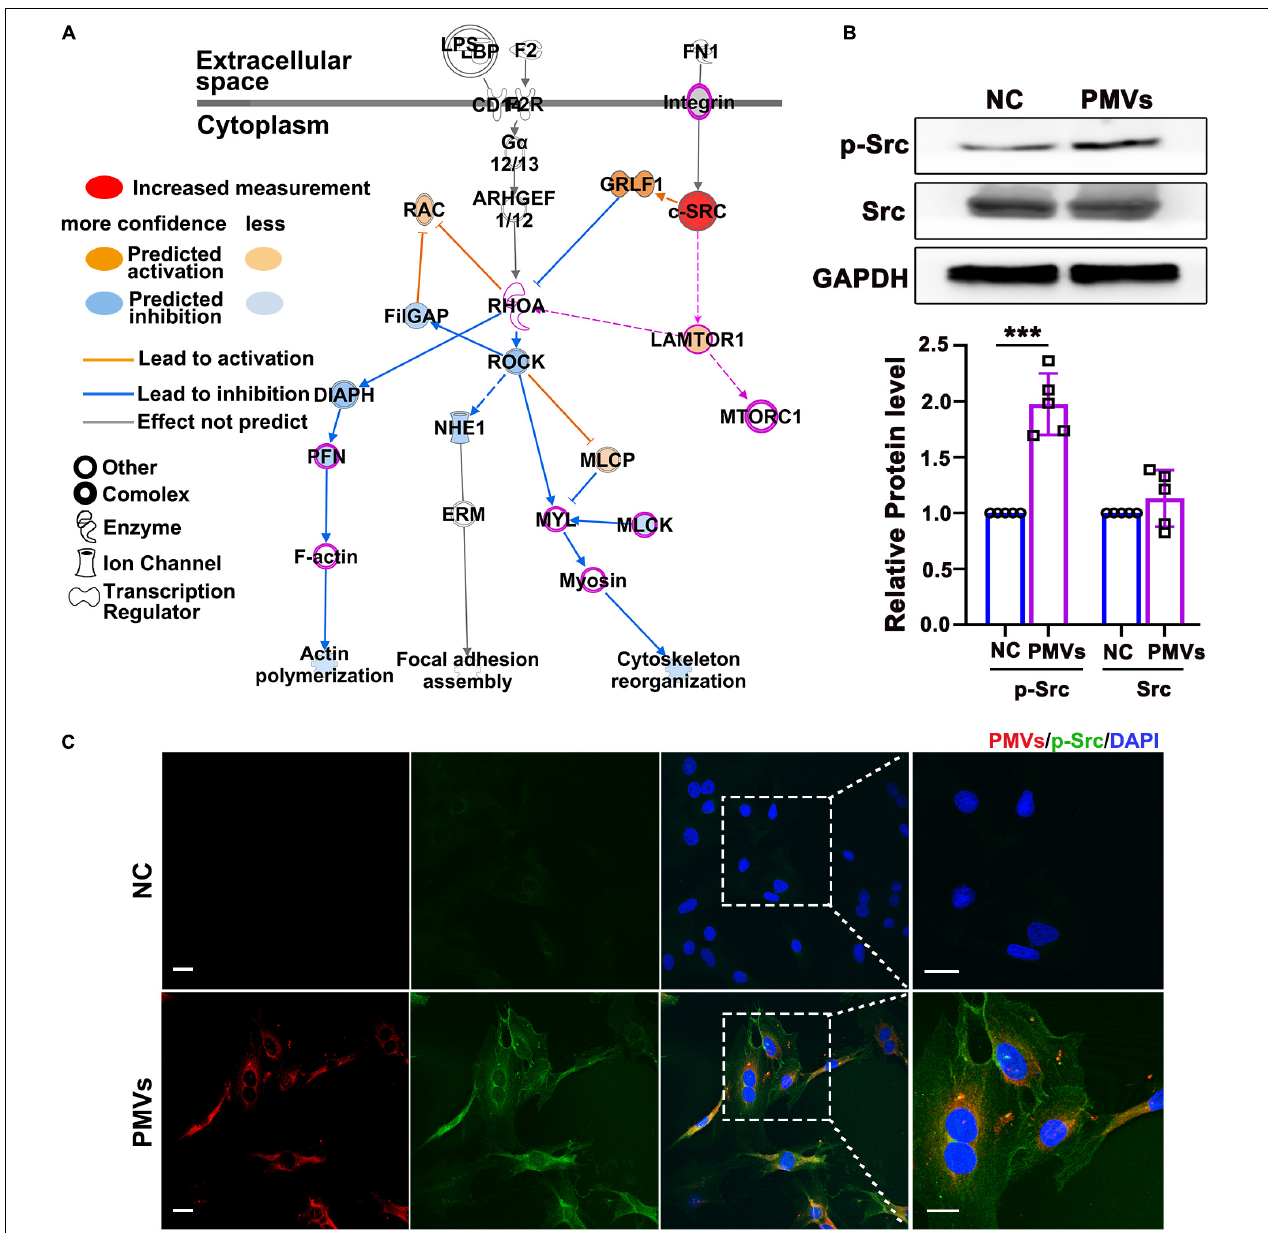
FIGURE 3 | PMVs induced Src phosphorylation. (A) Based on previously published proteomic data of PMVs, IPA bioinformatic analysis indicated that PMVs may induce Src activation, which may be the potential upstream molecule of Lamtor1 and participated in VSMC dedifferentiation. Solid lines for direct association and dotted lines for indirect or predicted association. (B) Western blot revealed that PMVs significantly increased the phosphorylation of Src, while did not change the expression of total Src ( n = 5). Data represent mean ± SD . *** P < 0.001. (C) Immunofluorescence staining indicated that the expression of p-Src (green) was significantly increased after incubated with PMVs (red). Nuclei were counterstained with DAPI (blue). Scale bars: 50 µ